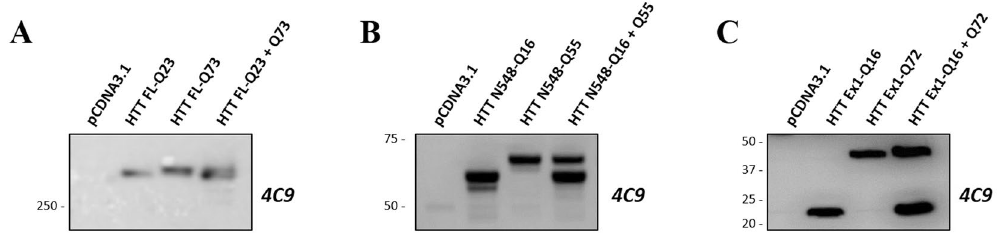
Figure 4. Representative Western blotting experiments of HEK293T cell lysates obtained by transient transfection with plasmids encoding HTT proteins, probed with antibody 4C9 (detecting HTT). ( A ) Western blot of HEK293T cell lysates transfected with either individual full length HTT proteins, wild type or mutant, or a cocktail of plasmids encoding both (of equivalent DNA concentration); samples were loaded on 6% Gel in order to better resolve the two full lengths proteins. ( B ) Western blot of HEK293T cell lysates transfected with either individual N548 HTT proteins, wild type or mutant, or a cocktail of plasmids encoding both (of equivalent DNA concentration). ( C ) Western blot of HEK293T cell lysates transfected with either individual exon 1 HTT proteins, wild type or mutant, or a cocktail of plasmids encoding both (of equivalent DNA concentration). In B and C samples were loaded on 4–12% gradient gel. The WB membranes in B and C were probed with anti-GAPDH antibody as loading control. GAPDH images are reported in supplementary information: Figs S2 and 3. It was not possible to test GAPDH as control in A because, the gel was run in order to resolve high molecular weight proteins, for distinguishing the wild type form from the mutant form of HTT. Indeed, the molecular weights included into the gel did not comprise proteins lower than 100 kDa (as GAPDH). All images were cropped from the original acquired file. Full-length blots are reported in Supplementary Information: Figures S1, S2 and